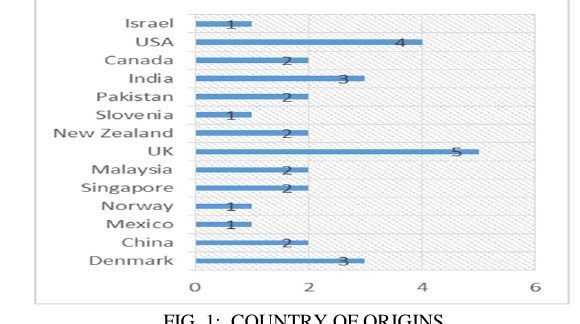
FIG. 1: COUNTRY OF